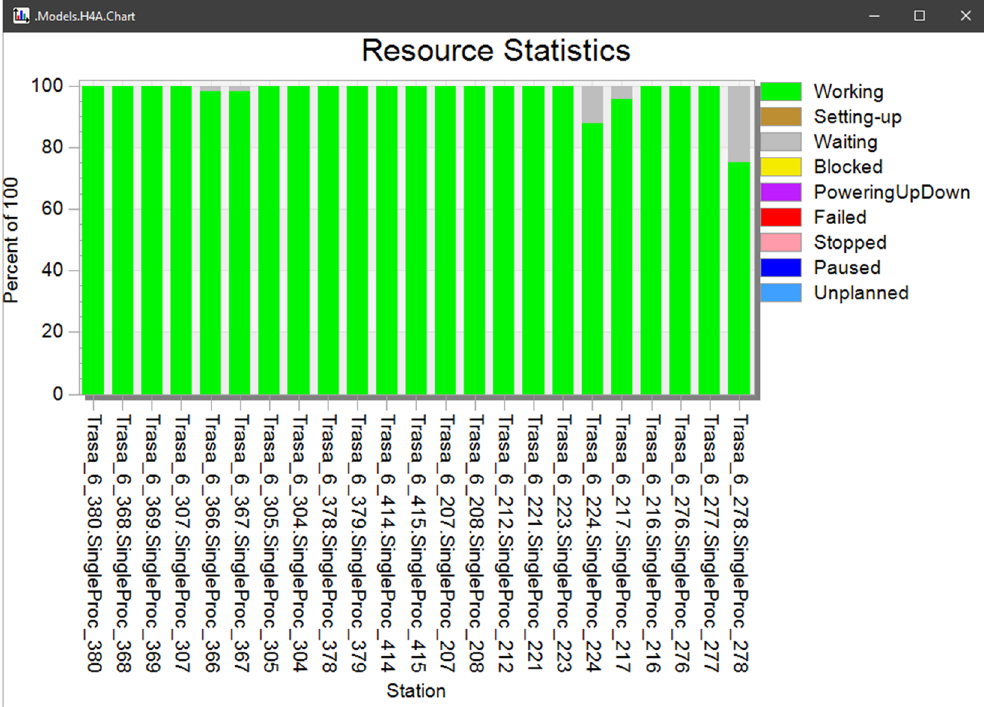
Figure 10: Histogram when supplying the line with one robotic AGV truck but at a higher travel